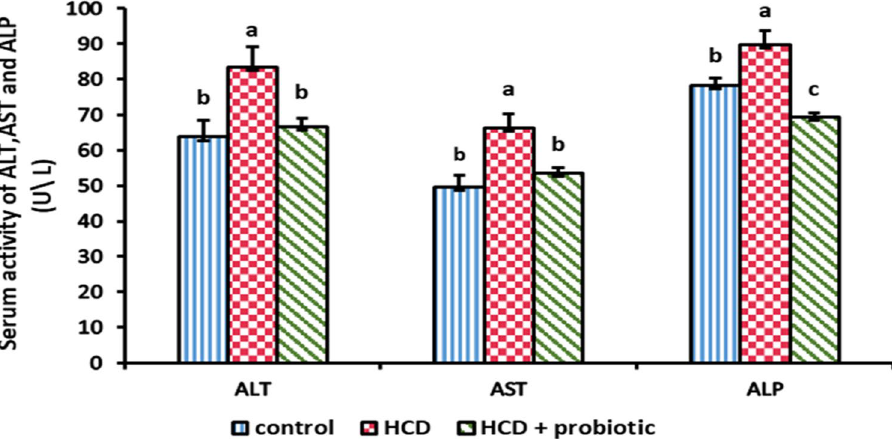
Figure 6. Effect of HCD supplementation and HCD with probiotic on liver enzymes [Alanine Transferase (ALT), Aspartate Transaminase (AST), and Alkaline Phosphatase